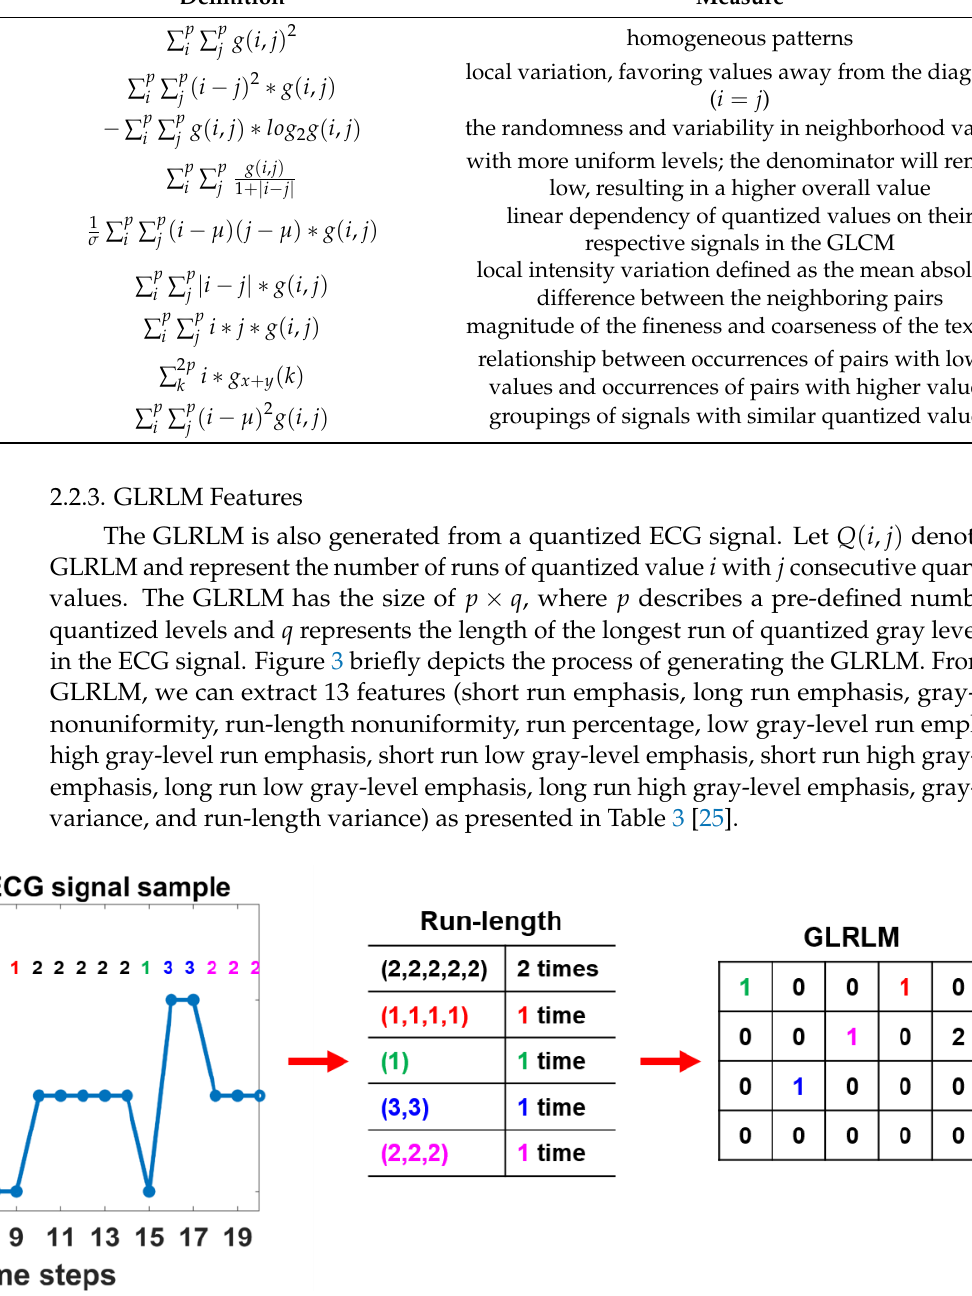
𝑄(𝑖,𝑗) 𝑞 𝑝 and 𝜇 𝑗 = 𝑗 𝑖 𝑁 𝑟𝑢𝑛